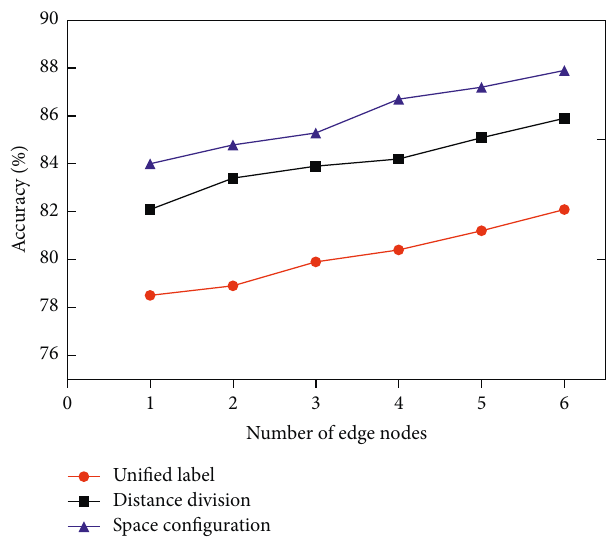
Figure 6: The influence of the number of edge nodes on the recognition Table 2: Edge node and cloud fusion recognition results (accuracy rate).